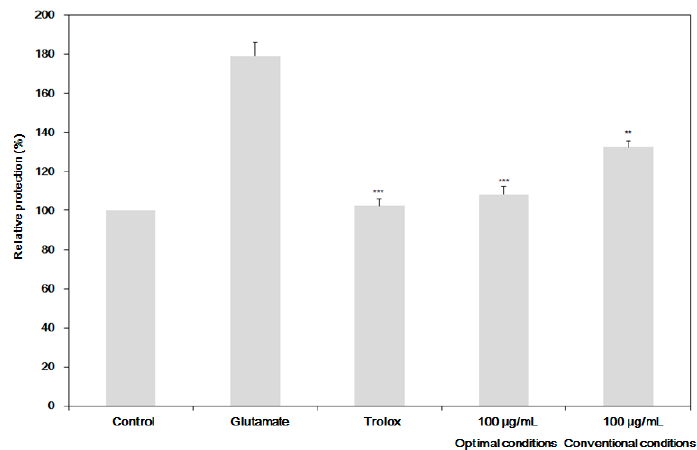
Figure 4. The reduction in Reactive Oxygen Species (ROS) production from the glutamate-induced mouse hippocampal neuronal cell line (HT22) by the addition of 100 ( μ g/mL) of the extracts from the optimal extraction conditions and a conventional extraction process. ** Significant at p < 0.01, *** Significant at p < 0.001.